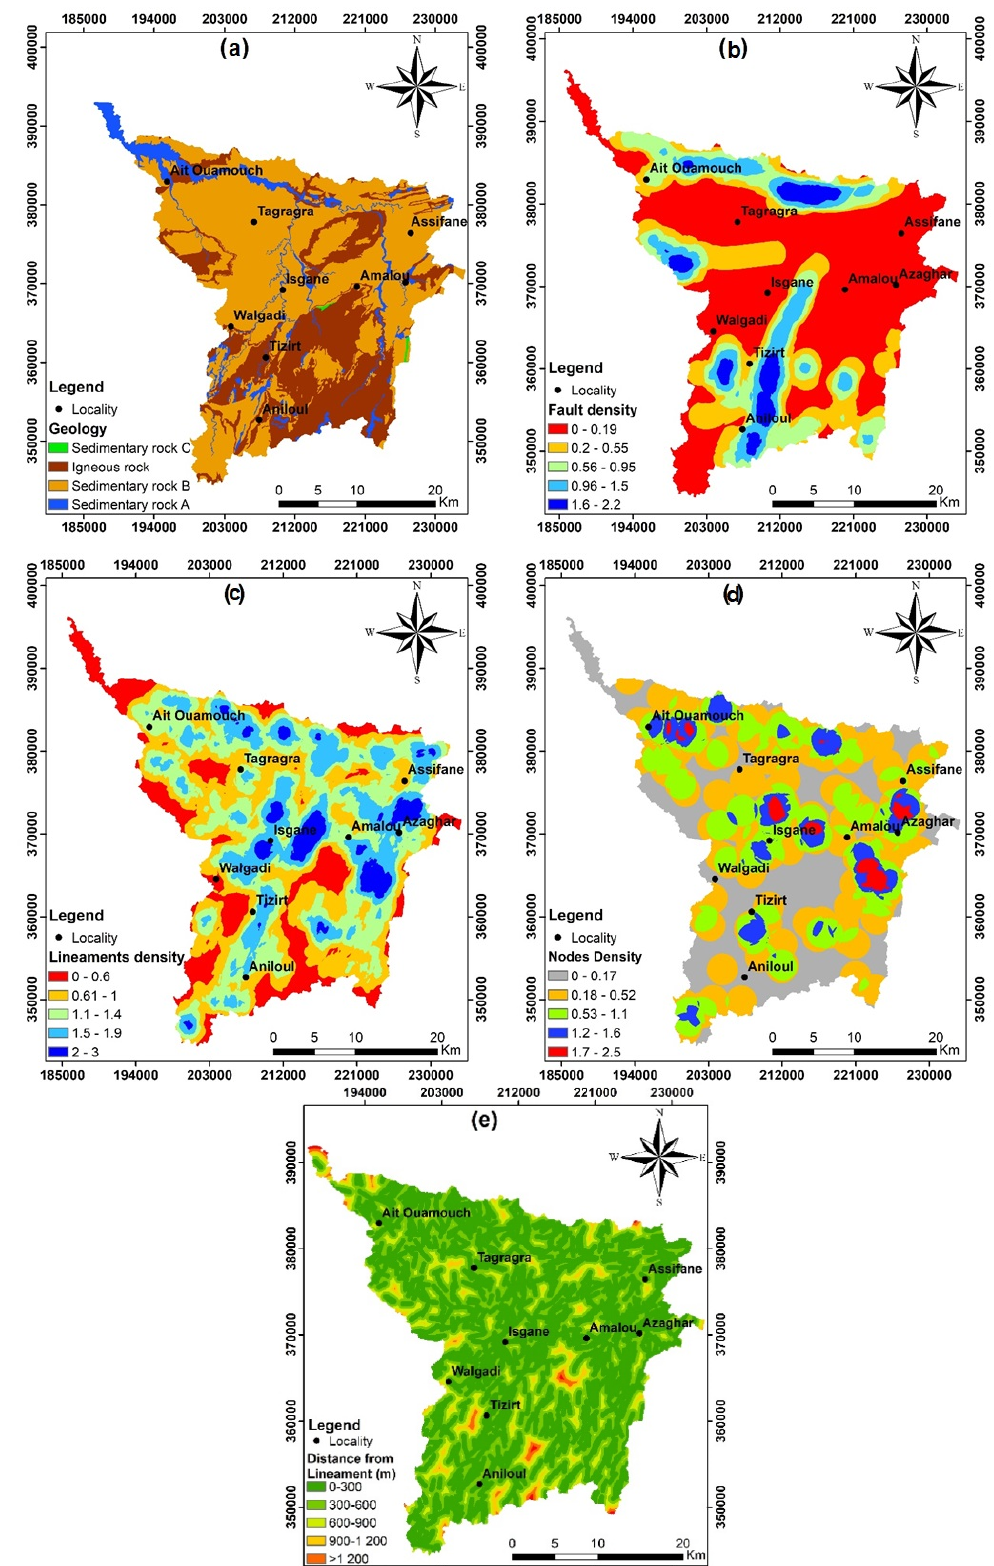
Figure 6. Geological factors influencing groundwater: ( a ) Lithology, ( b ) geological faults density, ( c ) lineaments density, ( d ) nodes density, ( e ) distance from lineaments.